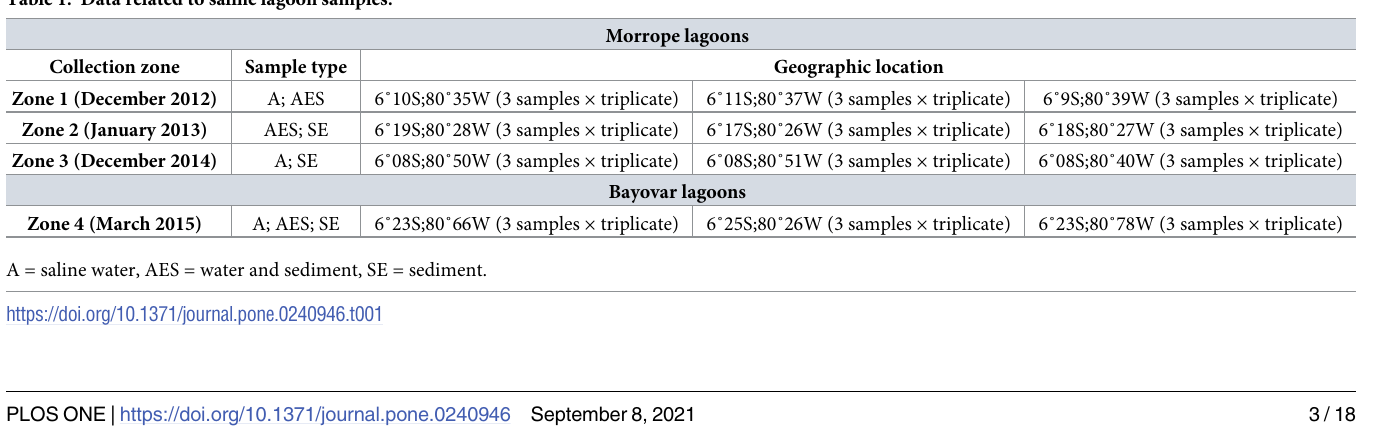
Fig 1. Sampling sites: a, b, c = lagoons 1, 2, and 3 (State Morrope); and d = lagoon 4 (State Bayovar). https://doi.org/10.1371/journal.pone.0240946.g001 Table 1 indicates the sources and locations from which samples were obtained. Samples were collected aseptically, placed in sterile plastic bags, and refrigerated at 4˚C for further pro- cessing in the Bacteriology Laboratory, Regional Hospital of Lambayeque. A flowchart depict- ing the methodological strategy adopted in this study is shown (S1 Fig). Table 1. Data related to saline lagoon